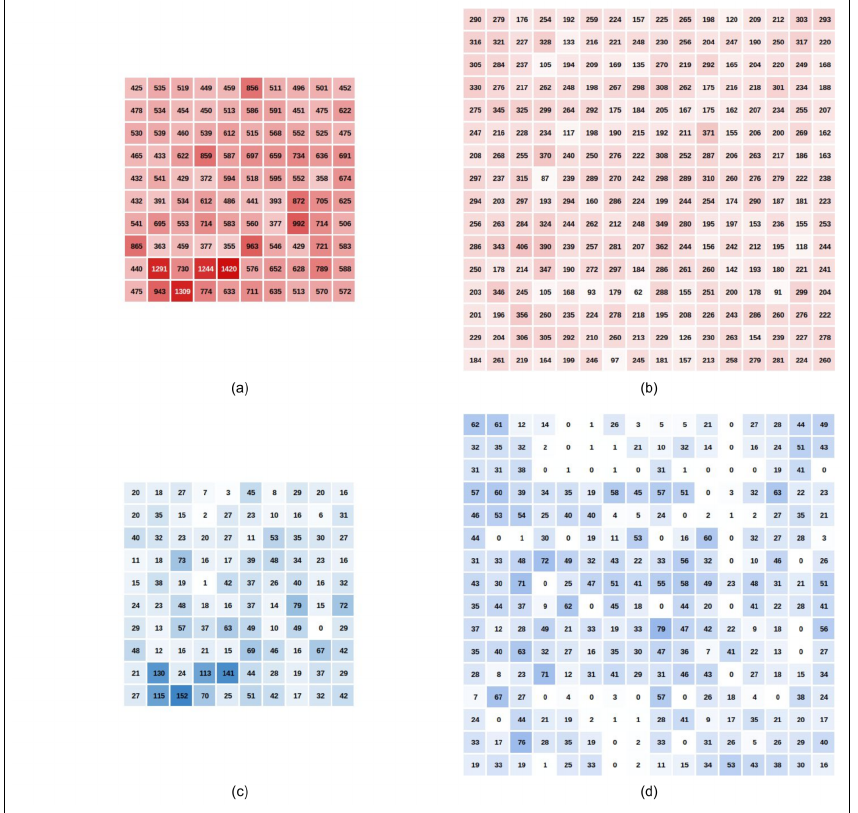
Figure 8. Written/Spoken digits neurons BMU counters during multimodal learning and inference using Hebb − Max BMU method: ( a ) MNIST SOM in learning; ( b ) S-MNIST SOM neurons during Norm learning; ( c ) MNIST SOM neurons during inference; ( d ) S-MNIST SOM neurons during